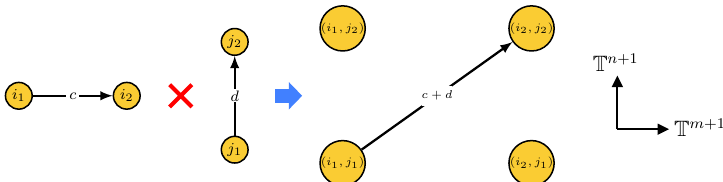
Figure 4 : The four cases of elements of P and Q giving rise to elements of P p